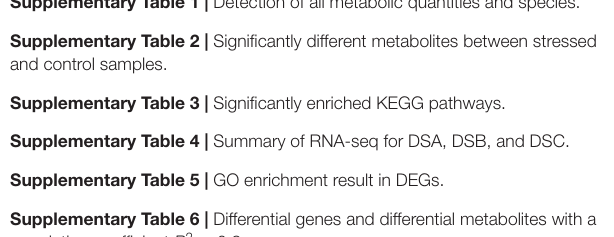
Supplementary Table 1 | Detection of all metabolic quantities and species.